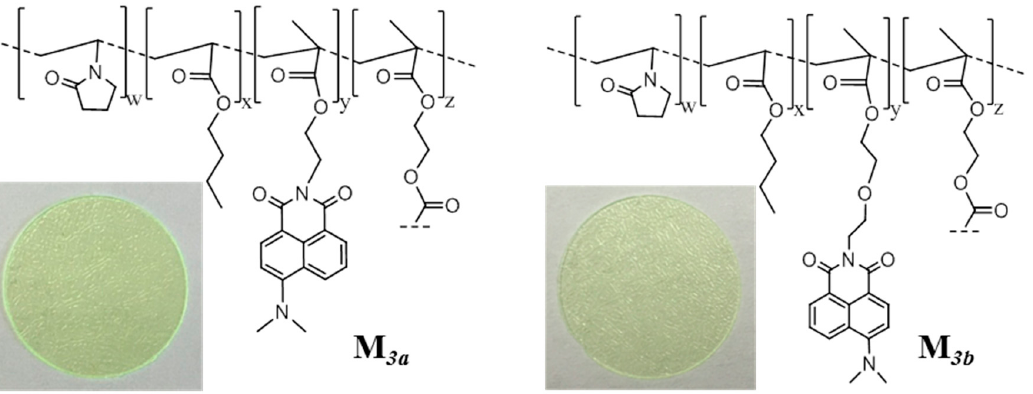
Figure 2. Chemical structure of membranes and photographs showing the self-standing sensory membranes, M 3a (left) and M 3b (right).